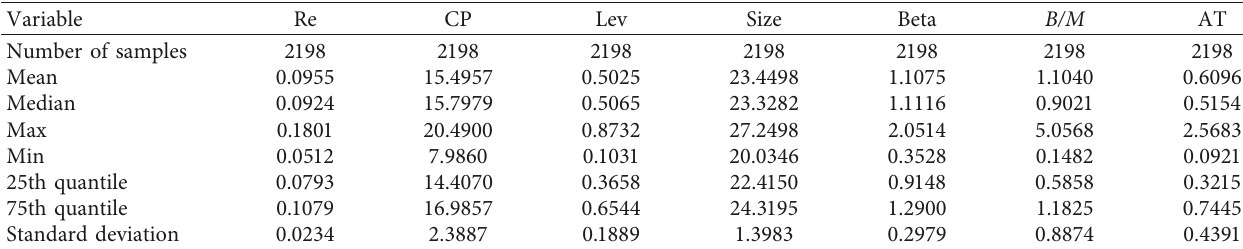
Table 2: Descriptive statistic of the whole samples.